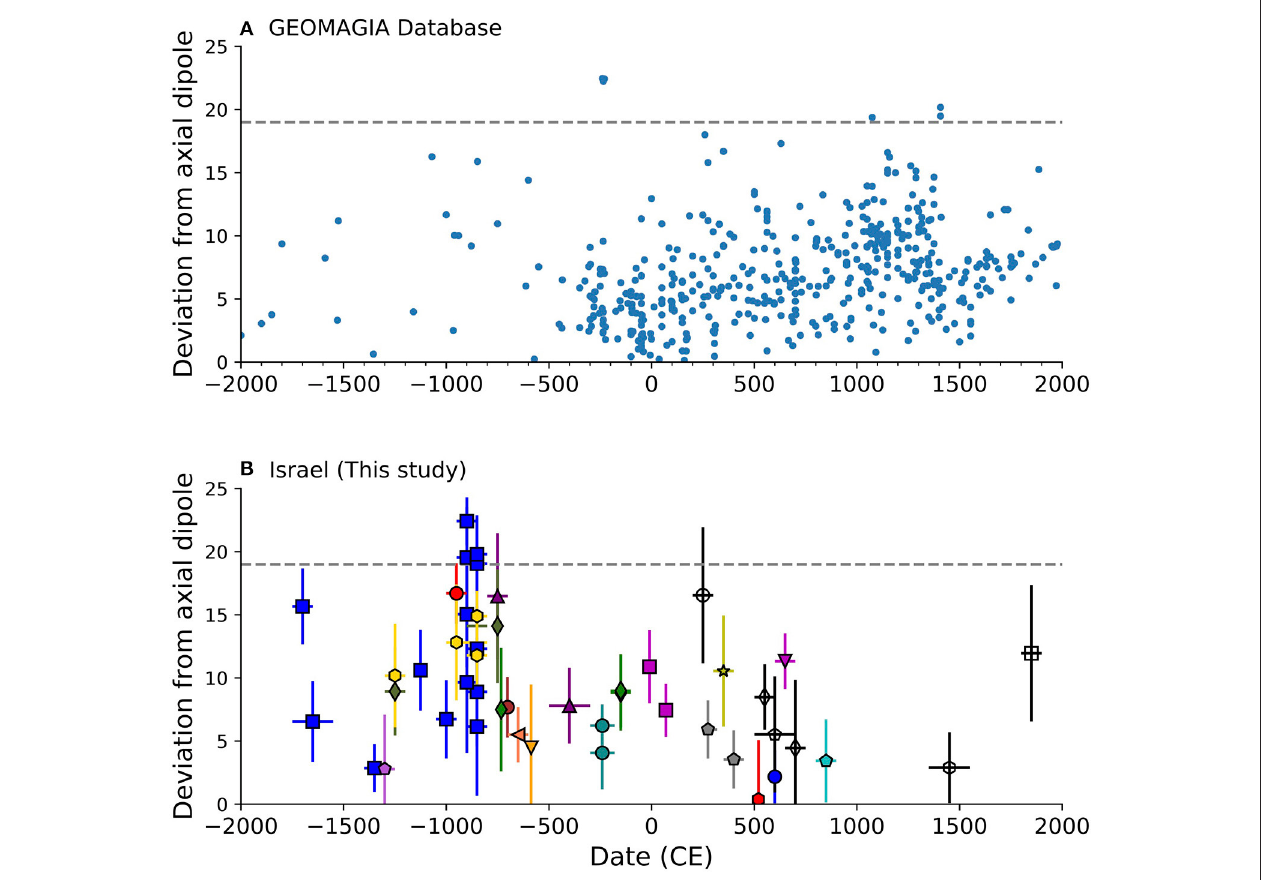
FIGURE 6 | Angular deviations from axial dipole. (A) Global paleomagnetic data from archaeological and volcanic sources downloaded from the GEOMAGIA50 database passing the acceptance criteria listed in Table 2 . (B) This study. The horizontal line shows high values exceeding 19 ◦ during the Levantine Iron Age Anomaly ( Figure 5